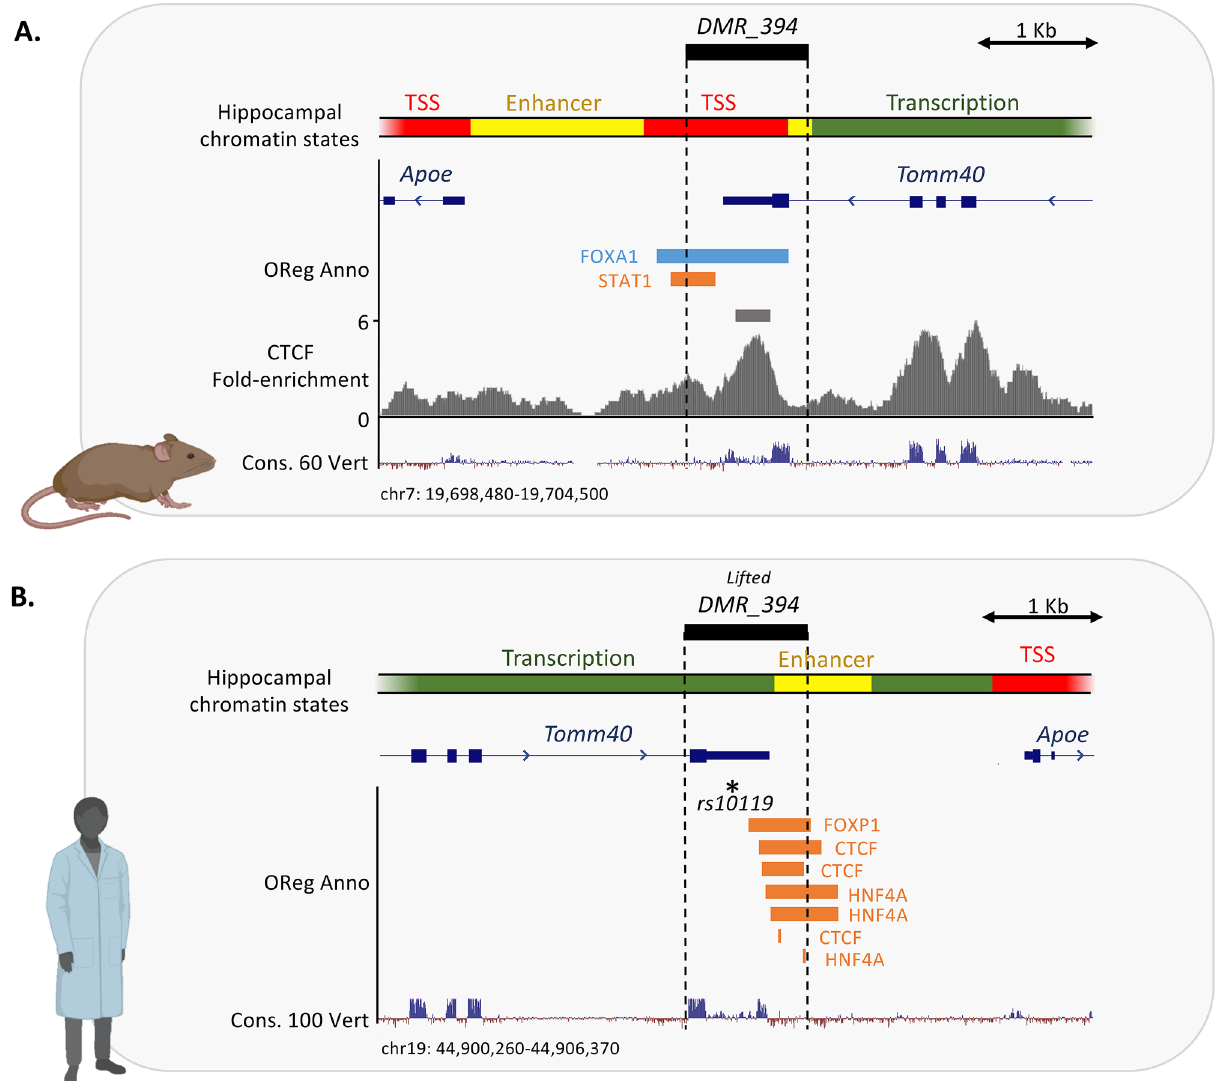
Figure 6. DMR_394 contains a putative hippocampal gene regulatory element conserved in mouse and human. ( A ) The epigenetic landscape at DMR_394 is shown in adult mouse hippocampus tissue. Enhancer states are shown on top. All transcription start site (TSS) states are marked red, all enhancer chromatin states are colored yellow and all transcription-related chromatin states are shaded green. Open Regulatory Annotation (OReg Anno) Database elements are marked blue (regulatory regions) and orange (transcription factor binding site), with the name of the transcription factor believed to bind each element shown next to them. CTCF ChIP-seq fold-enrichment and significant peaks are shown in gray pileup and gray bar, respectively. ( B ) The epigenetic landscape at the human-equivalent of DMR_394 is shown. Chromatin state and OReg Anno colors match those described in panel